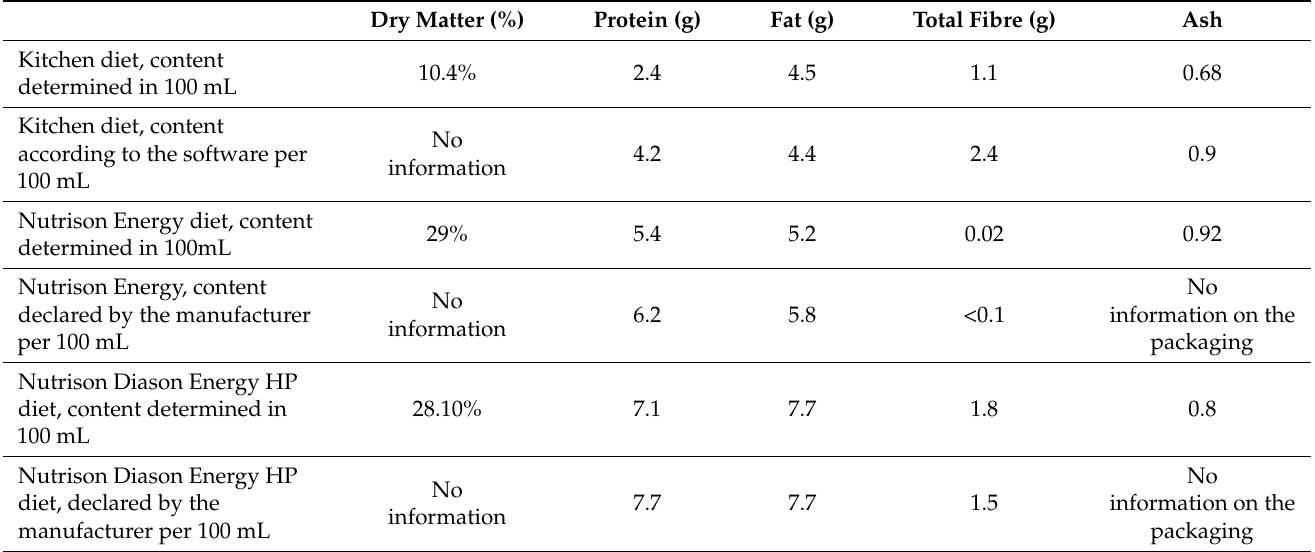
Table 2. Nutritional content according to nutrition software vs. laboratory determinations in the diets.